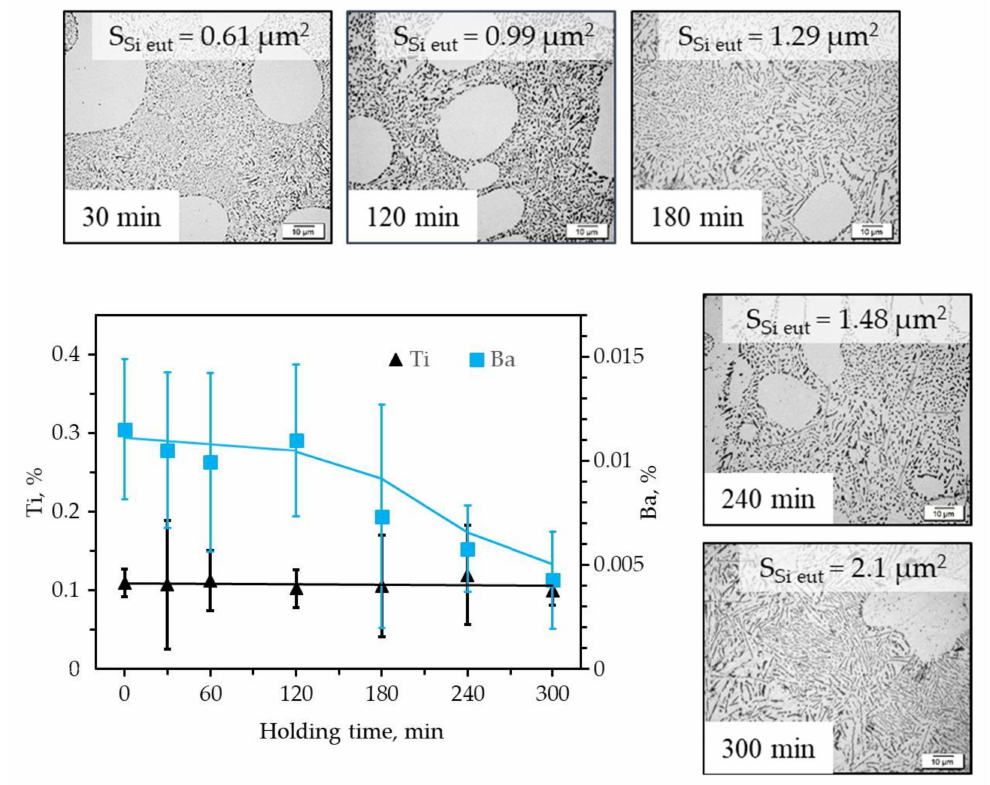
Figure 11. Microstructure and concentration (wt.%) of modifying elements in Al-12% wtSi alloy treated with a complex